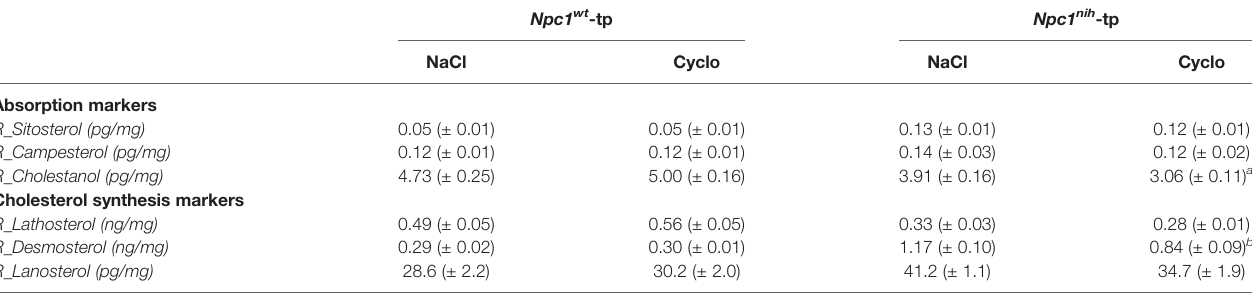
TABLE 2 | Hepatic ratios of non-cholesterol sterols to cholesterol.